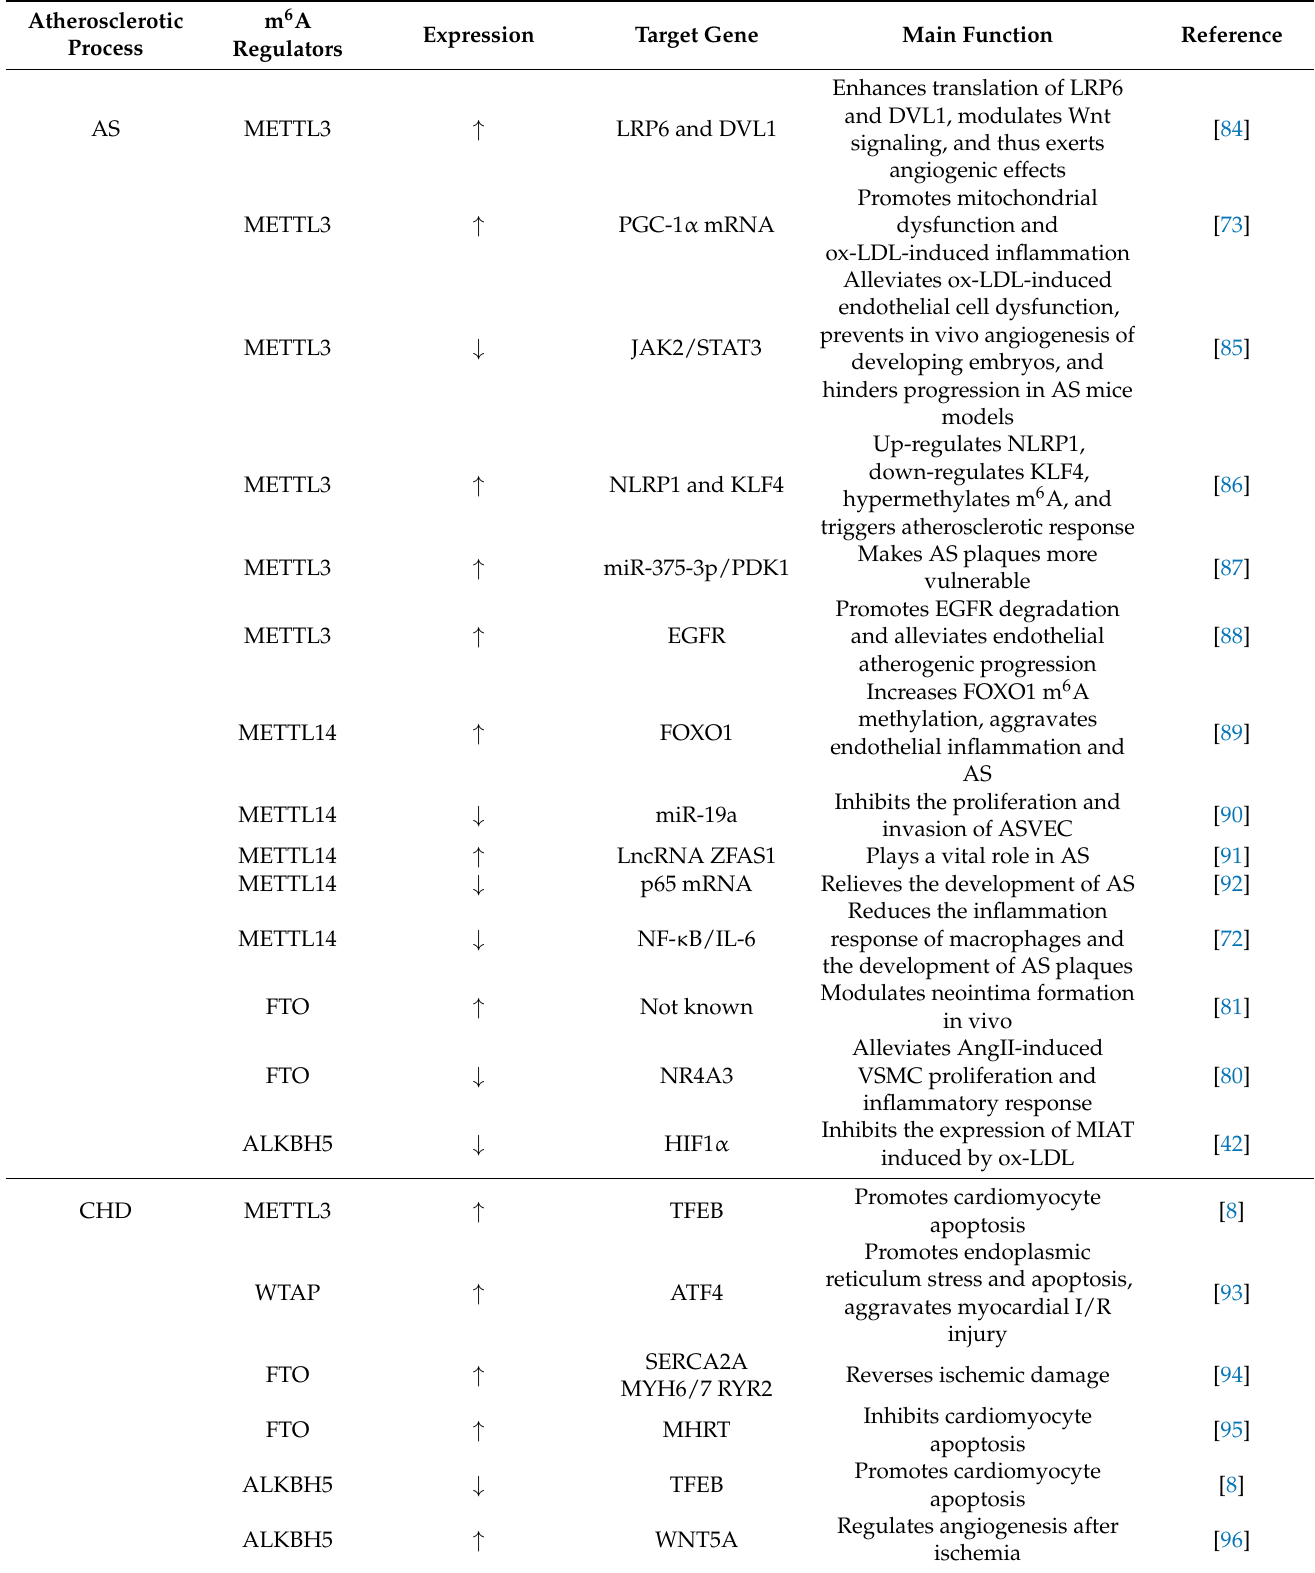
Table 1. m 6 A methylation regulator-guided epigenetic modification in AS and